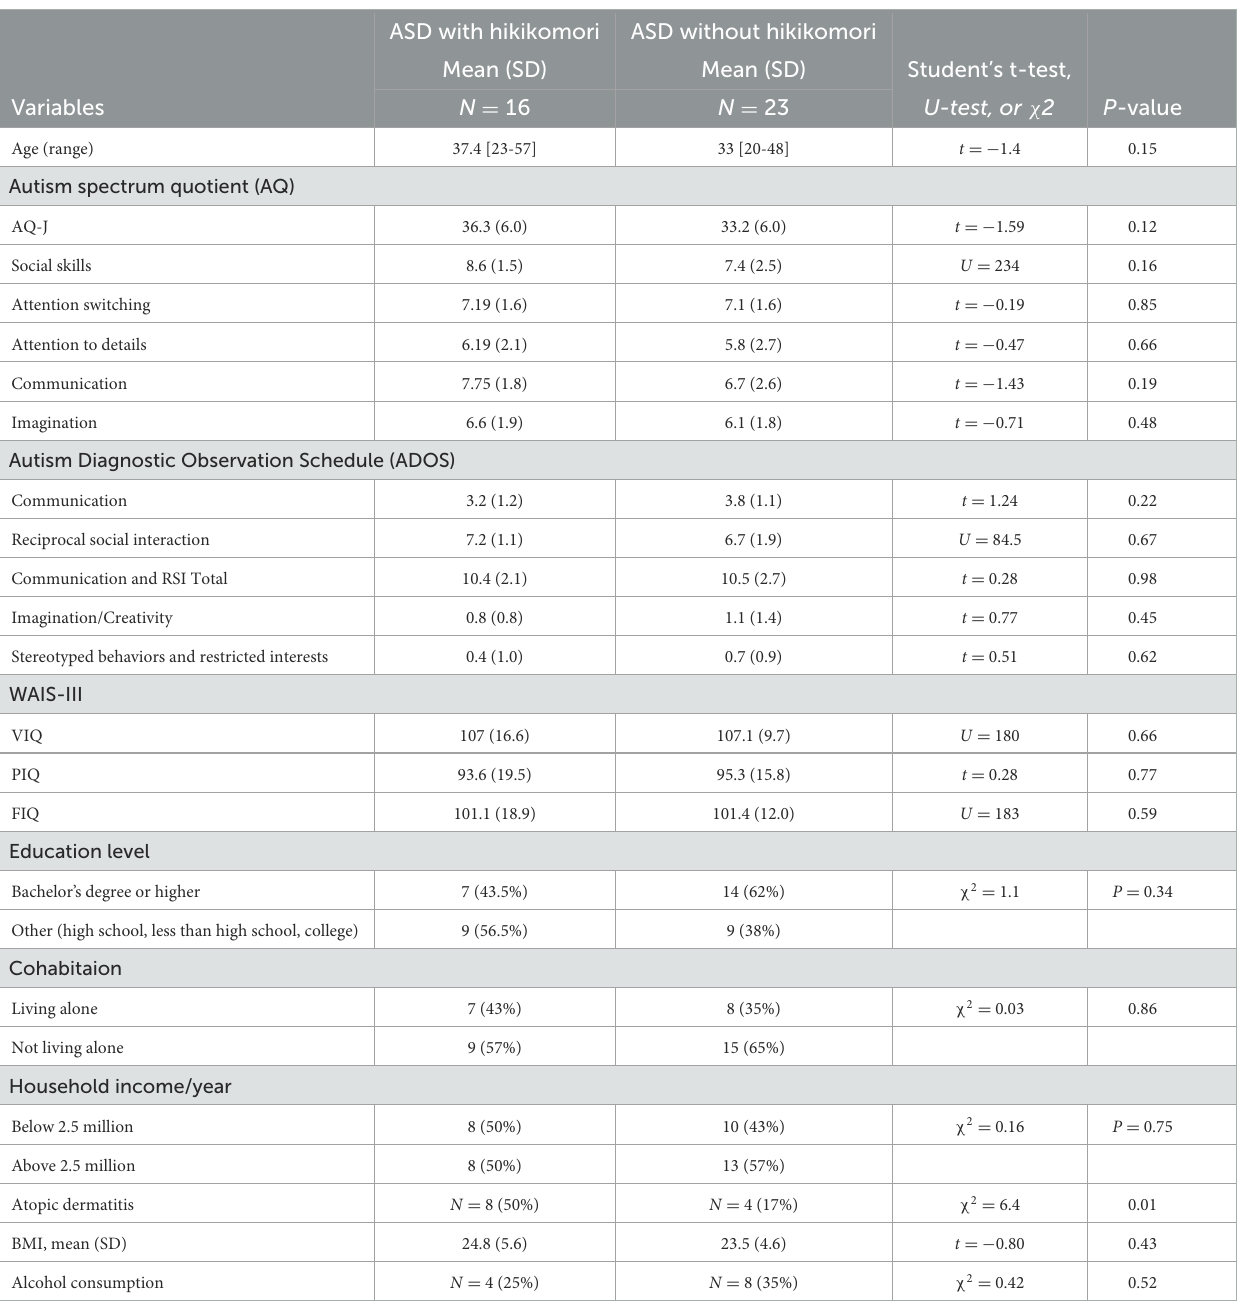
TABLE 1 Patient characteristics and